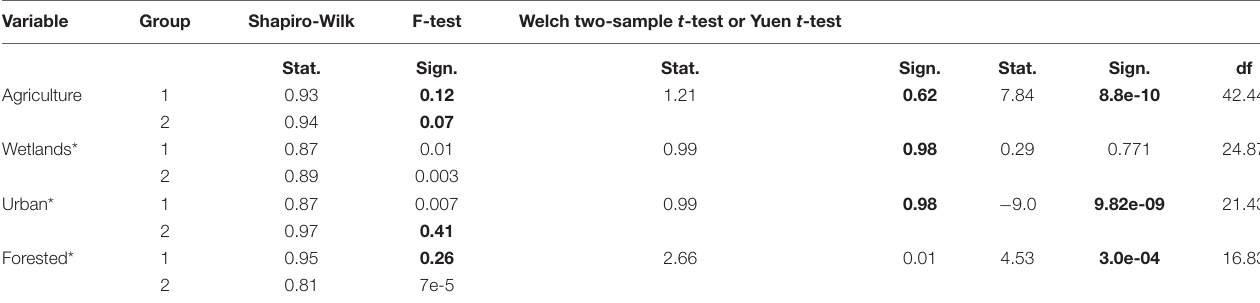
TABLE 2 | Two-sample t -test of the landscape variables analyzed for 54 sampling sites in Illinois.